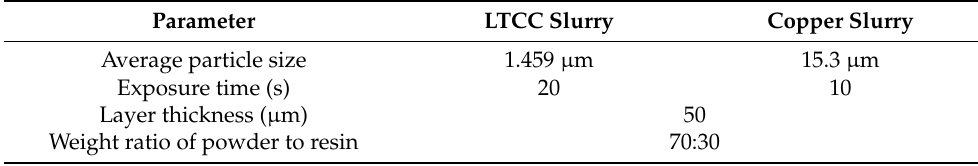
Table 1. Printing parameters for LTCC and Copper slurries.